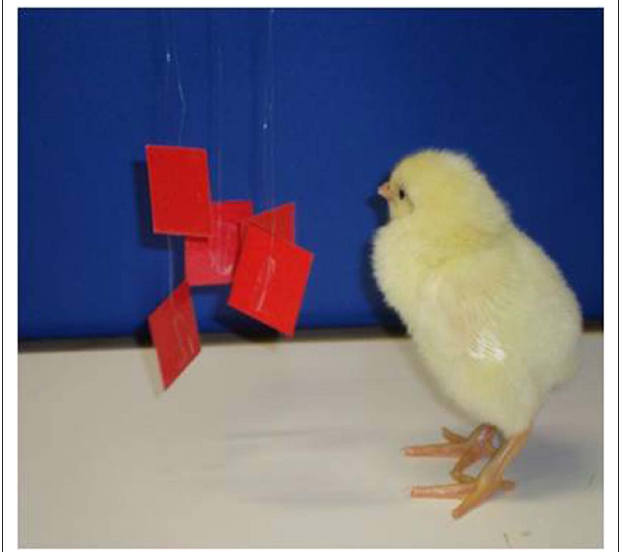
Figure 1 | An example of a stimulus used during imprinting phase, each stimulus was composed of five identical red bi-dimensional squares.